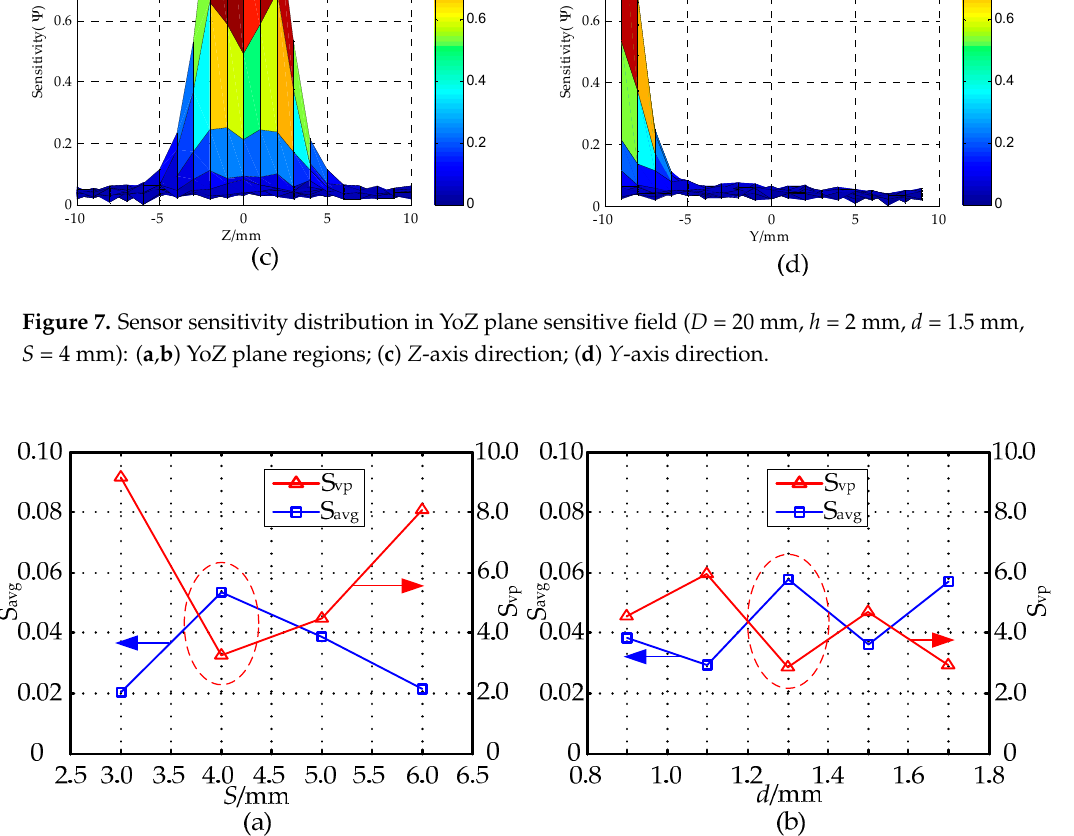
Figure 8. The effect of the MCP geometry on S avg and S vp : ( a ) effect of the parameter S ( D = 20 mm, h = 2 mm, d = 1.5 mm); ( b ) effect of the parameter d ( D = 20 mm, h = 2 mm, S = 4 mm).